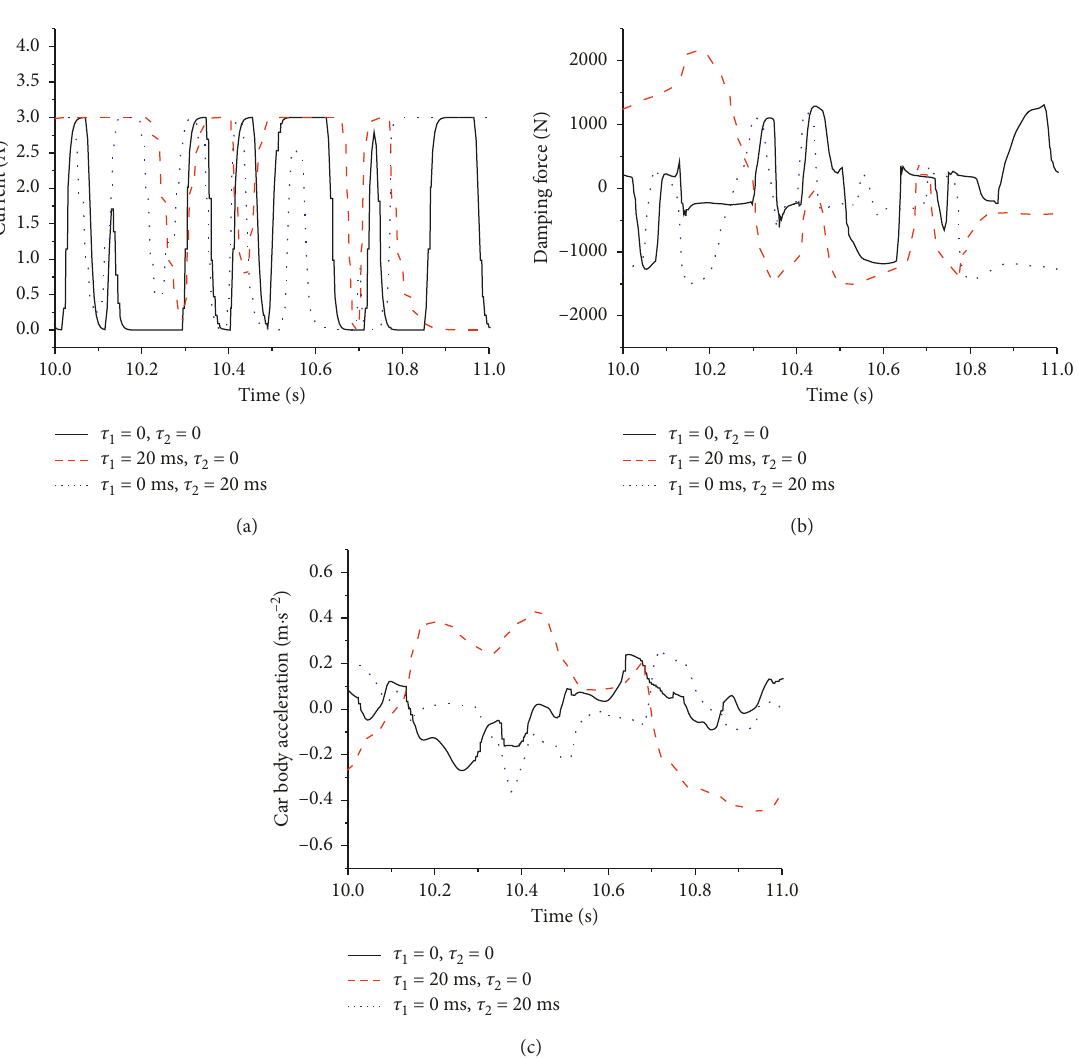
Figure 22: Effects of acquisition time delay and actuation time delay on currents, damping force, and car body acceleration. (a) Current vs. time. (b) Damping force vs. time. (c) Lateral acceleration of the car body.